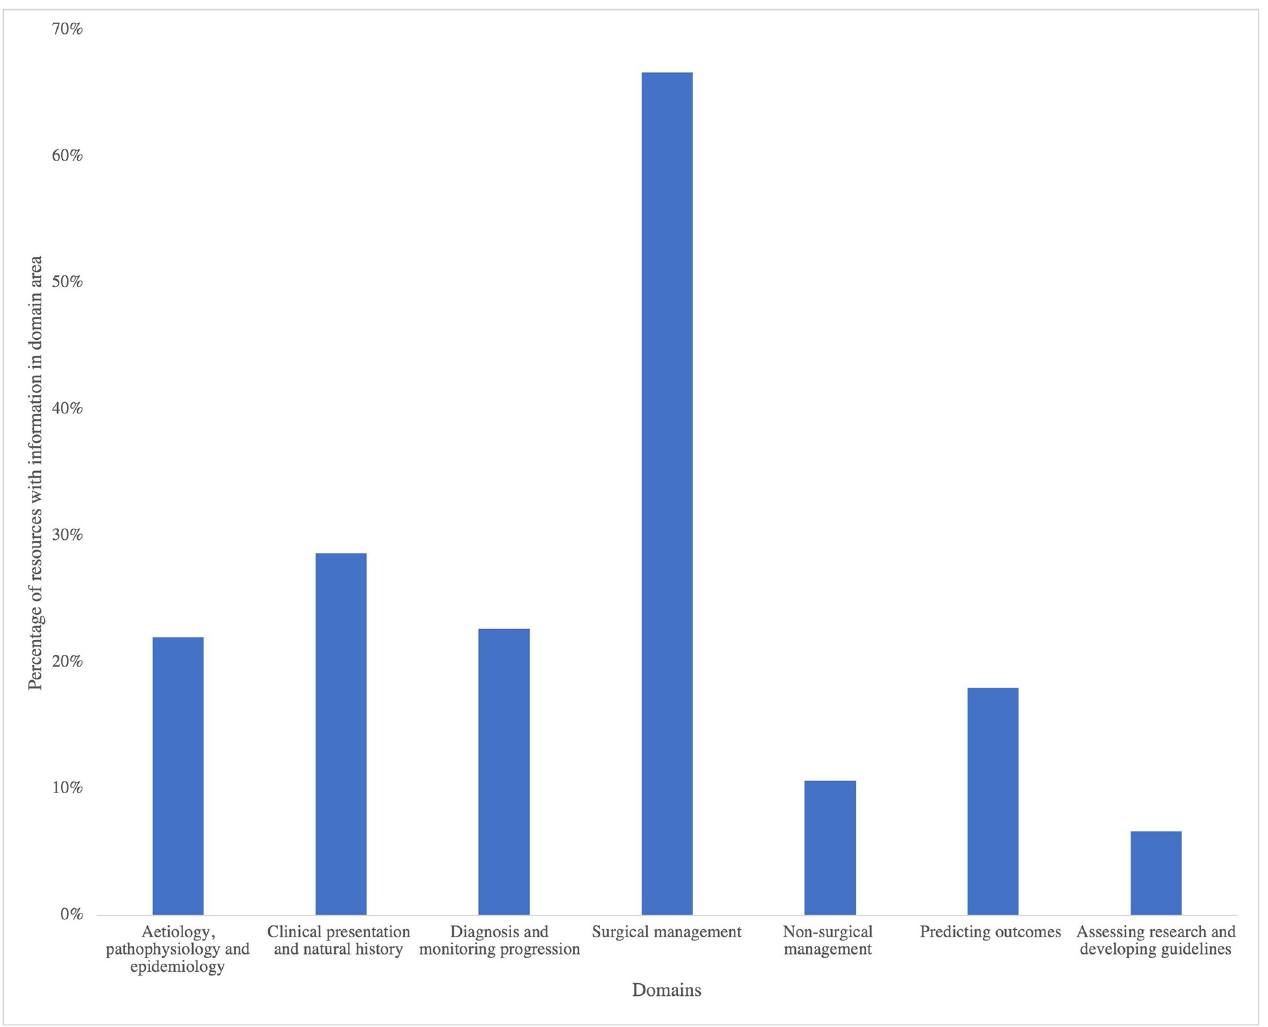
Fig 2. Percentage of educational resources on each of the 7 DCM domains. The most common domain was surgical management (67%). The least common domain was assessing research and developing guidelines (7%).